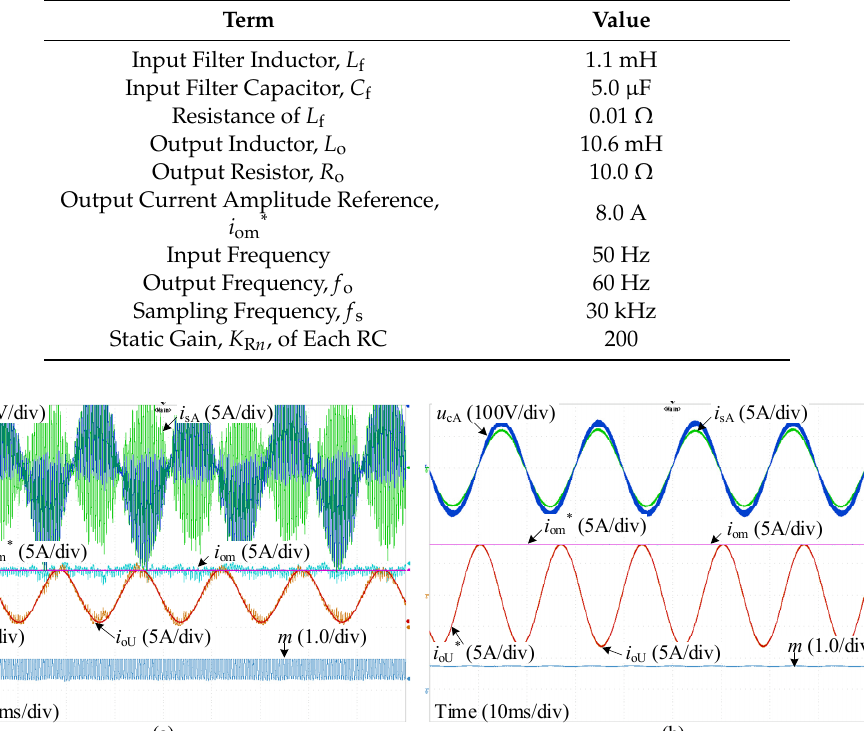
Figure 6. Experimental prototype of the unidirectional matrix converter. Table 1. Parameters of the UMC prototype.